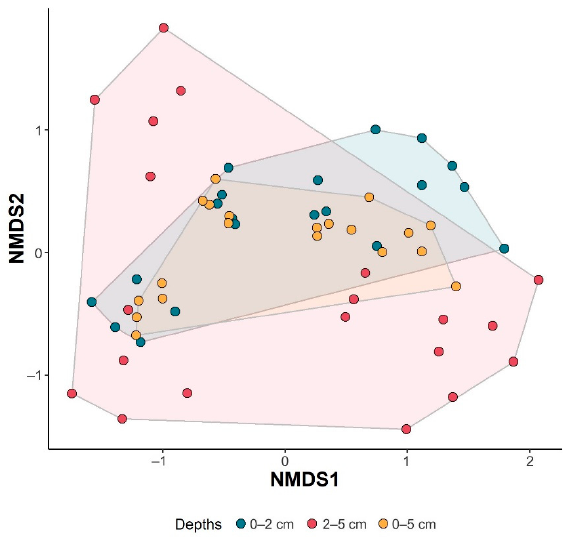
Figure 11. Non-metric multidimensional scaling (NMDS) of three study layers from the continental slope of Potiguar Basin based on the tree of foraminiferal species composition: blue—surface layer (0–2 cm); red—subsurface layer (2–5 cm); yellow—integrated layer (0–5 cm).